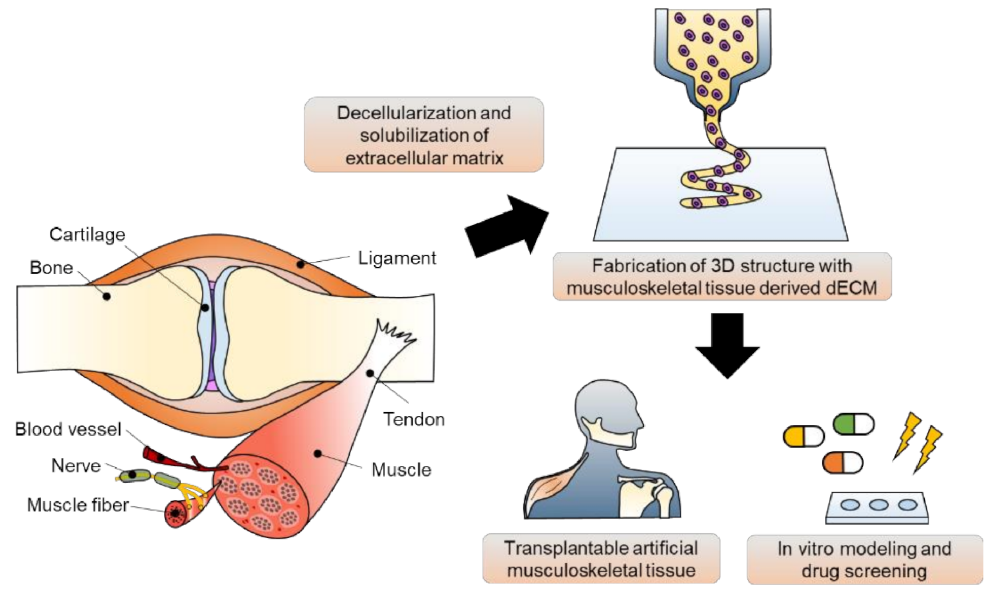
Figure 1. Musculoskeletal tissue derived decellularized extracellular matrix (dECM) bioink prepara- tion and its applications in 3D bioprinting-based musculoskeletal tissue